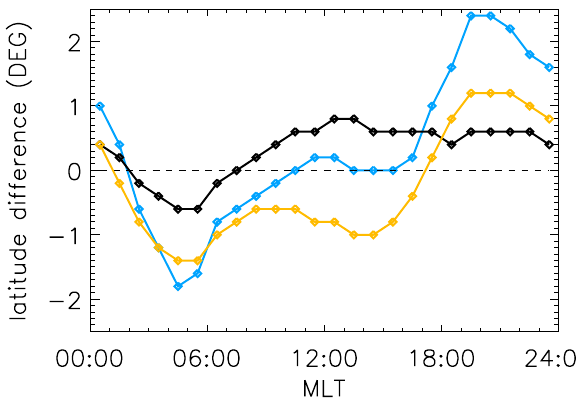
Fig. 3. Mode of OCB proxy latitude differences for λ WIC − λ SI − 12 (blue), λ WIC − λ SI − 13 (black) and λ SI − 13 − λ SI − 12 (yellow). The estimated widths of the distributions (explained in the text) are of order 2 ◦ and the estimated errors on the modes are < 0.01 ◦